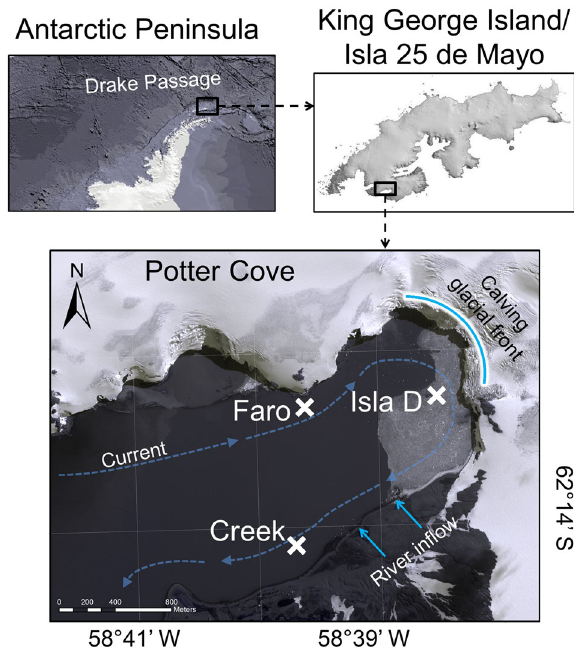
Fig. 1 Study site. In situ measurements and sediment sampling were conducted at three sites — Faro, Creek, and Isla D (positions are marked with a cross). The curved, bright blue line marks the front of the Fourcade glacier. The bright blue arrows indicate river run-offs from the creeks, supplied mainly by melting glacier, permafrost and snow. The dashed blue arrows indicate the direction of the main current in Potter Cove. Owing to this current direction, Faro is considered an upstream site experiencing little glacial melt disturbance, Isla D is a glacier front site under high glacial melt in fl uence and Creek is located downstream of a melt water river, experiencing glacial melt disturbance in addition to meltwater plume in fl uence. Satellite picture from Potter Cove taken on 3 November 2013 from Digital Globe 84